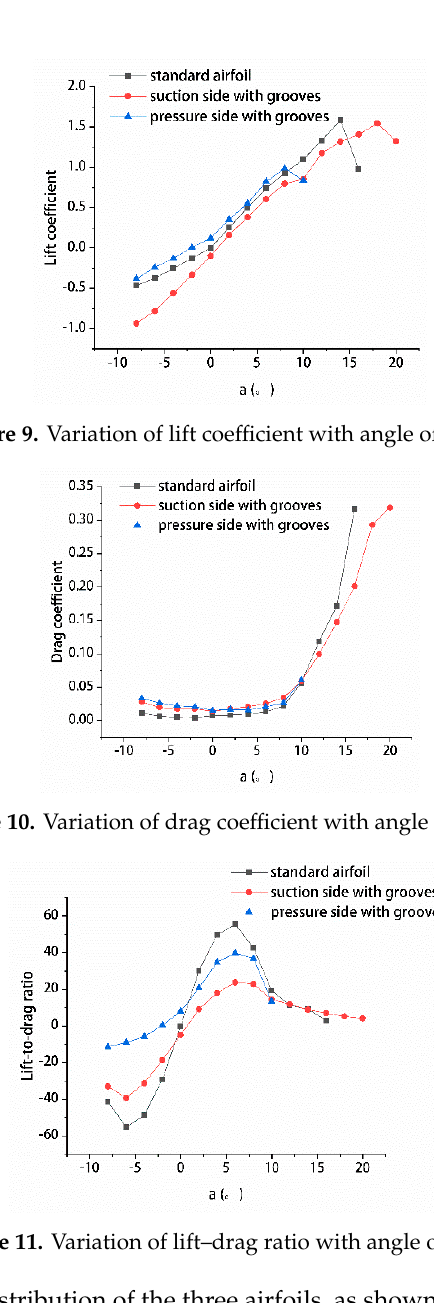
Figure 12. 4° angle of attack, speed distribution of grooves on the suction side.